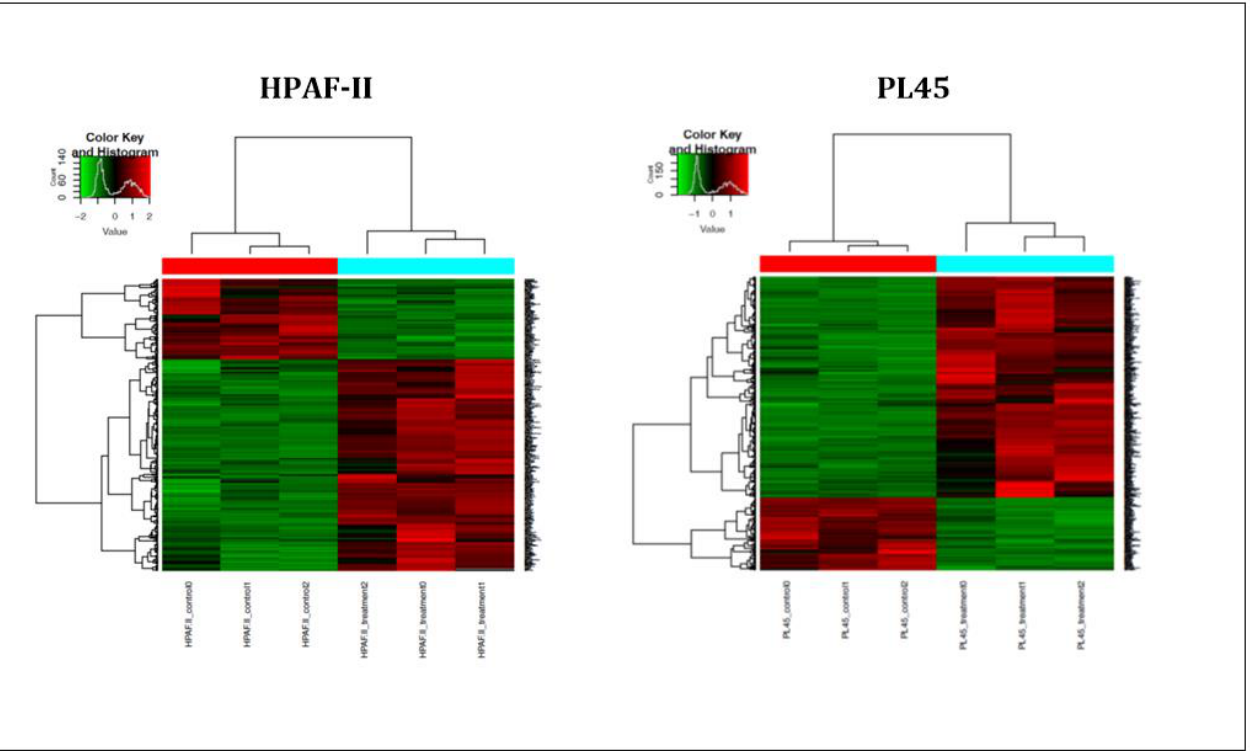
Figure 4. Heat map summarizing the CSE effects on PL45 and HPAF-II. The most significantly down- or upregulated genes are presented. The data is presented in a matrix format, with rows representing individual genes and columns representing each sample. Each cell in the matrix represents the expression level of a gene featured in an individual sample. Red and green reflect the high and low expression levels, respectively, as indicated in the scale bar (log2-transformed scale).